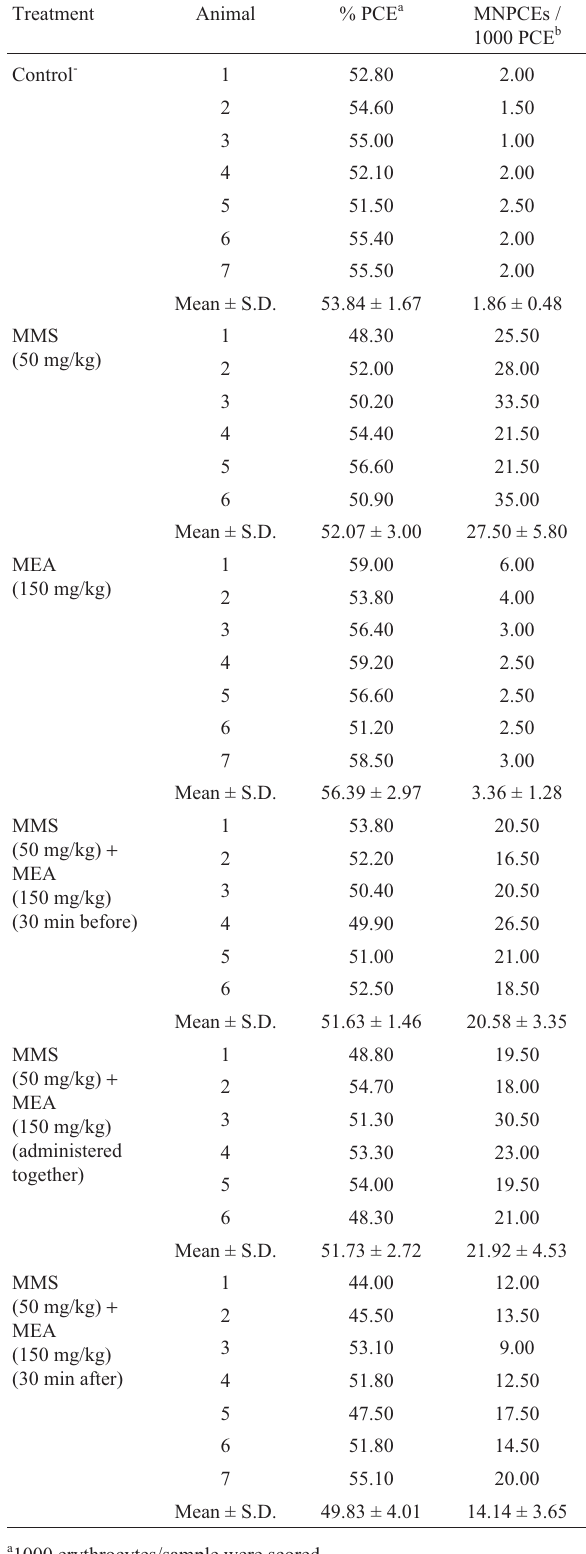
Table 1 - The effect of MEA on the frequencies of MNPCEs in bone marrow of mice after treatment with MMS. Treatment